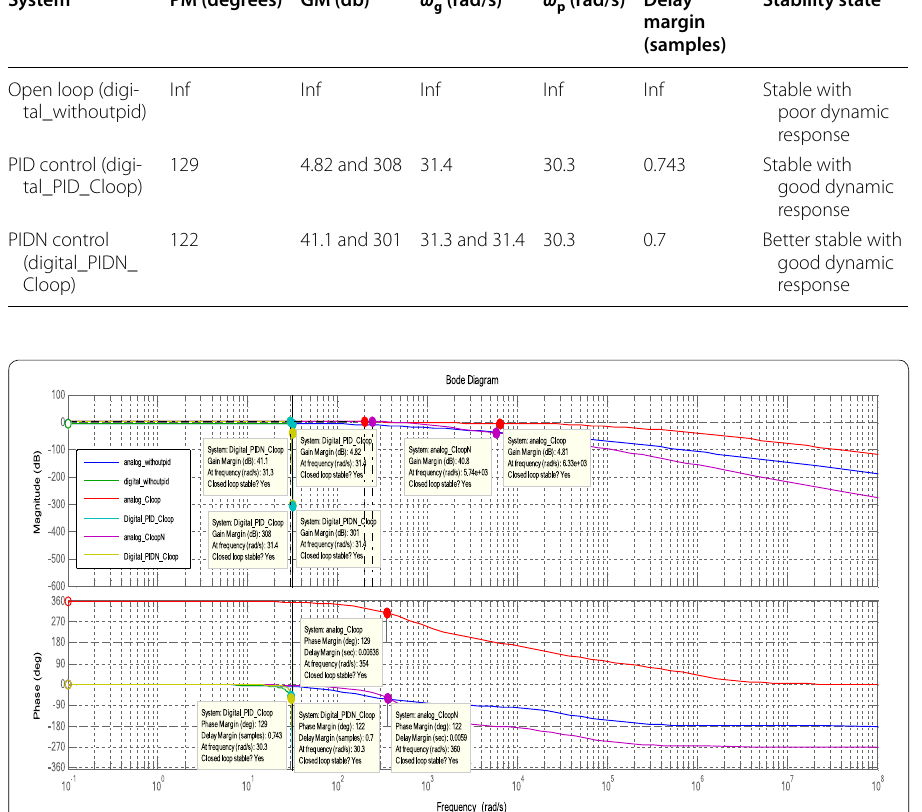
Fig. 15 Mixed domain frequency response of BBC in buck mode in open loop and closed loop with PID and